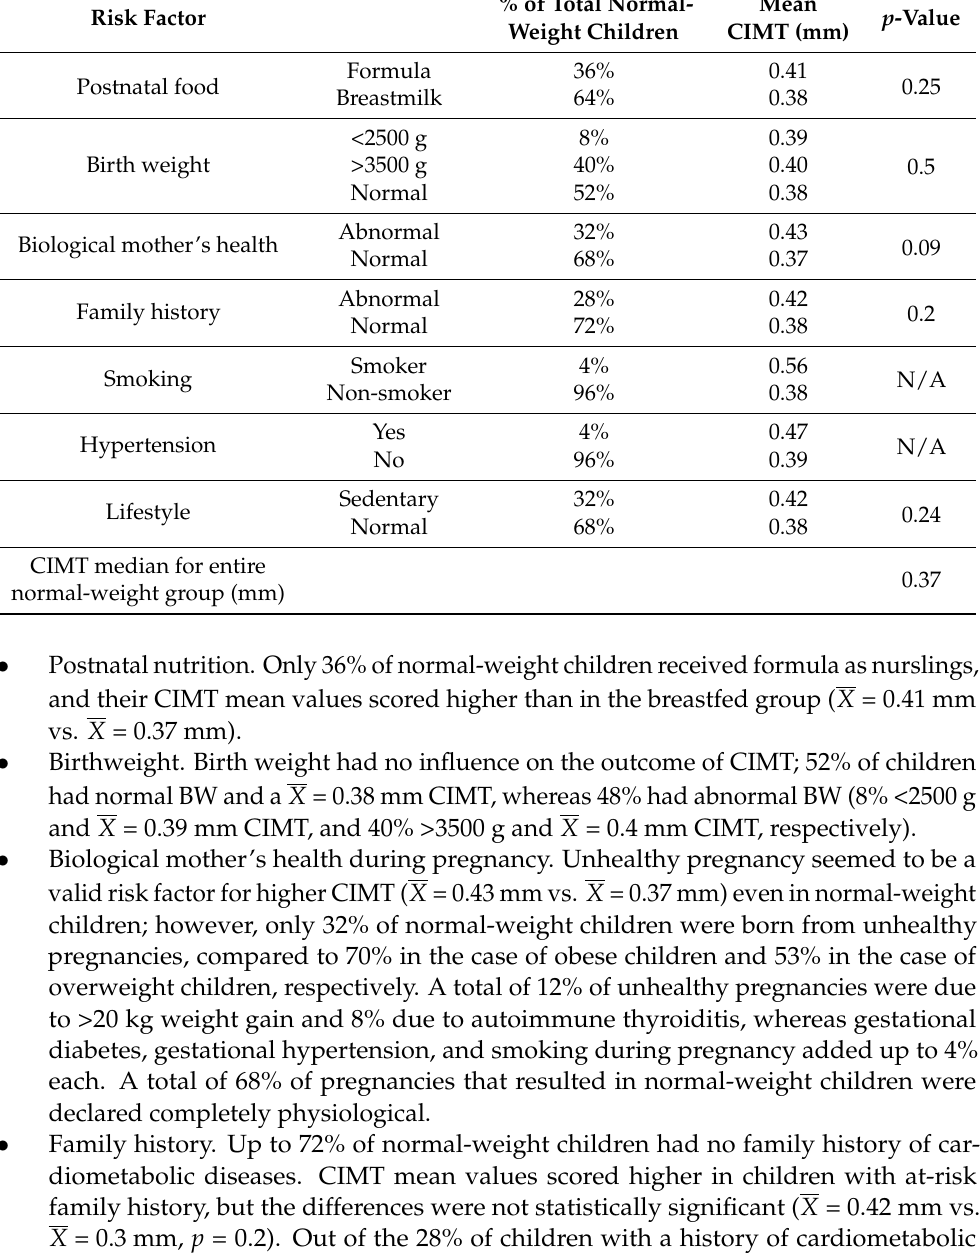
Table 5. Mean CIMT in the presence of different risk factors in normal-weight children. Risk Factor Postnatal food